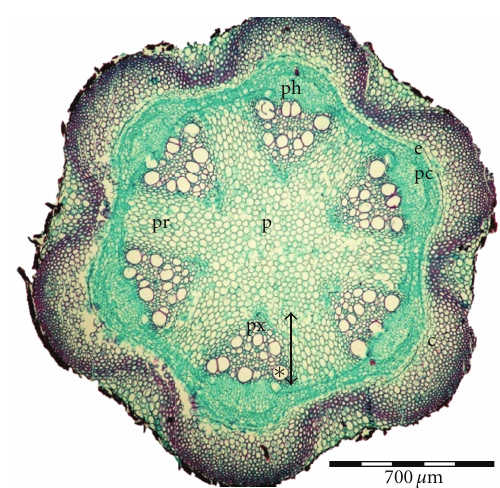
Figure 1: Transverse section of Clematis “Solidarno´s´c” stem, p: pith, pr: pith rays, ph: phloem, px: protoxylem, ∗ : vessel of meta- xylem, (cid:5) : xylem, e: endodermis, c: cortex with lamellar collenchy- mas, pc: